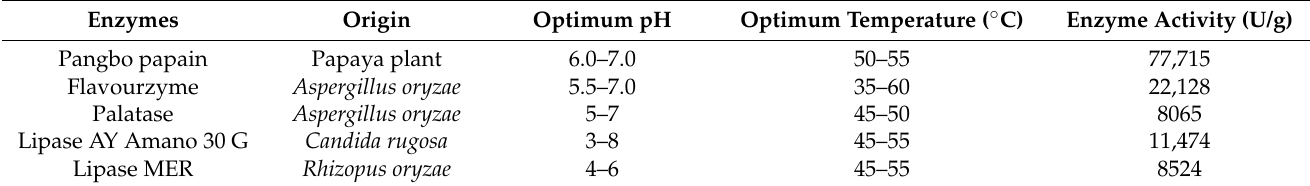
Table 6. Features and specifications of proteases and lipases.